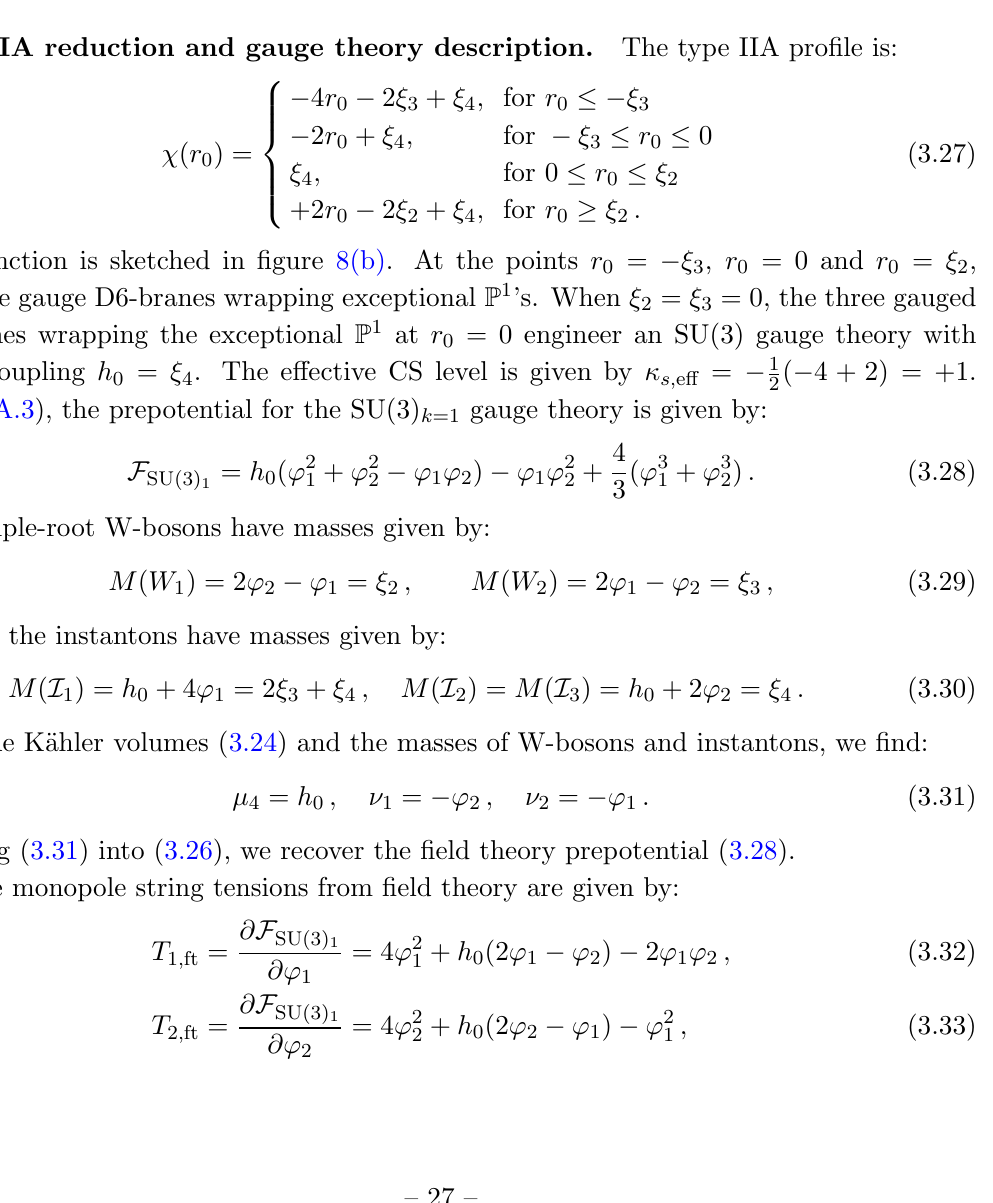
Figure 8 . Resolution (a) of the E 12 ; 1 singularity and its vertical